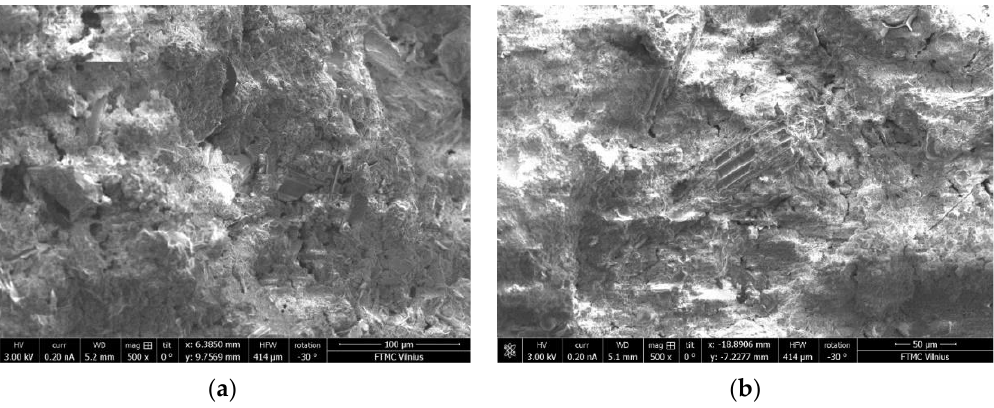
Figure 17. Microstructure of the samples cured at 20 °C: ( a ) CS-0.40-20; ( b ) CS-1.20-20 (magnification 500).